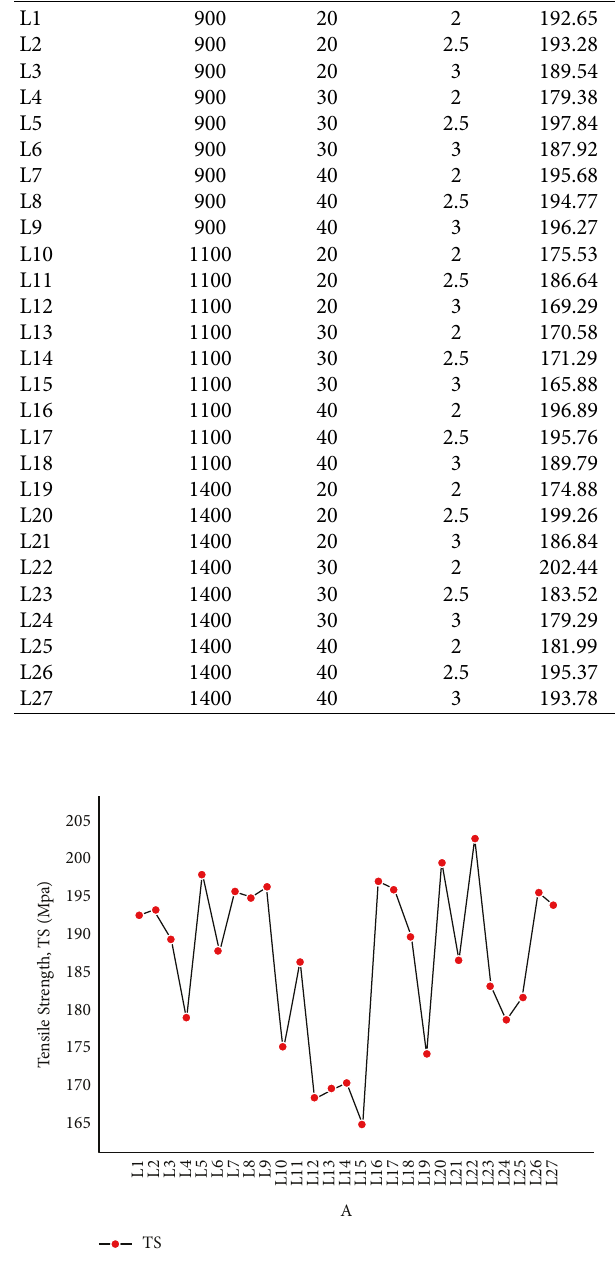
Figure 9: Overall tensile strength